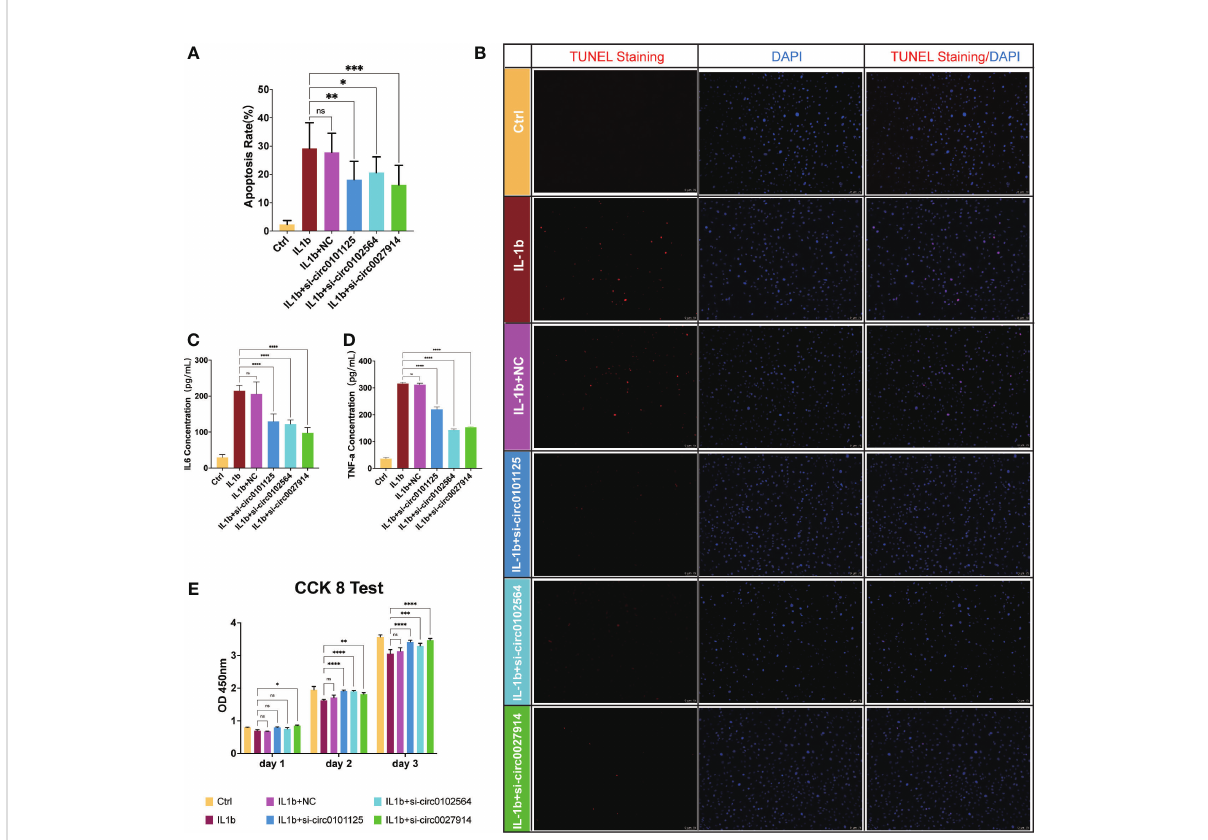
FIGURE 9 Veri fi cation of the function of the three hub DECs in an in vitro IL-1 b -mediated OA chondrocyte model. Representative fi gures of TUNEL staining (B) and quantitative analysis (A) demonstrated the alleviation of apoptosis chondrocytes in siRNAs from three hub DECs. ELISA of IL-6 (C) and TNF- a (D) demonstrated the inhibition of in fl ammatory cytokine secretion with silencing intervention of these three DECs. (E) The CCK- 8 test demonstrated that proliferation of IL-1 b -treated chondrocytes was restored by silencing these three hub DECs on 1, 2, or 3